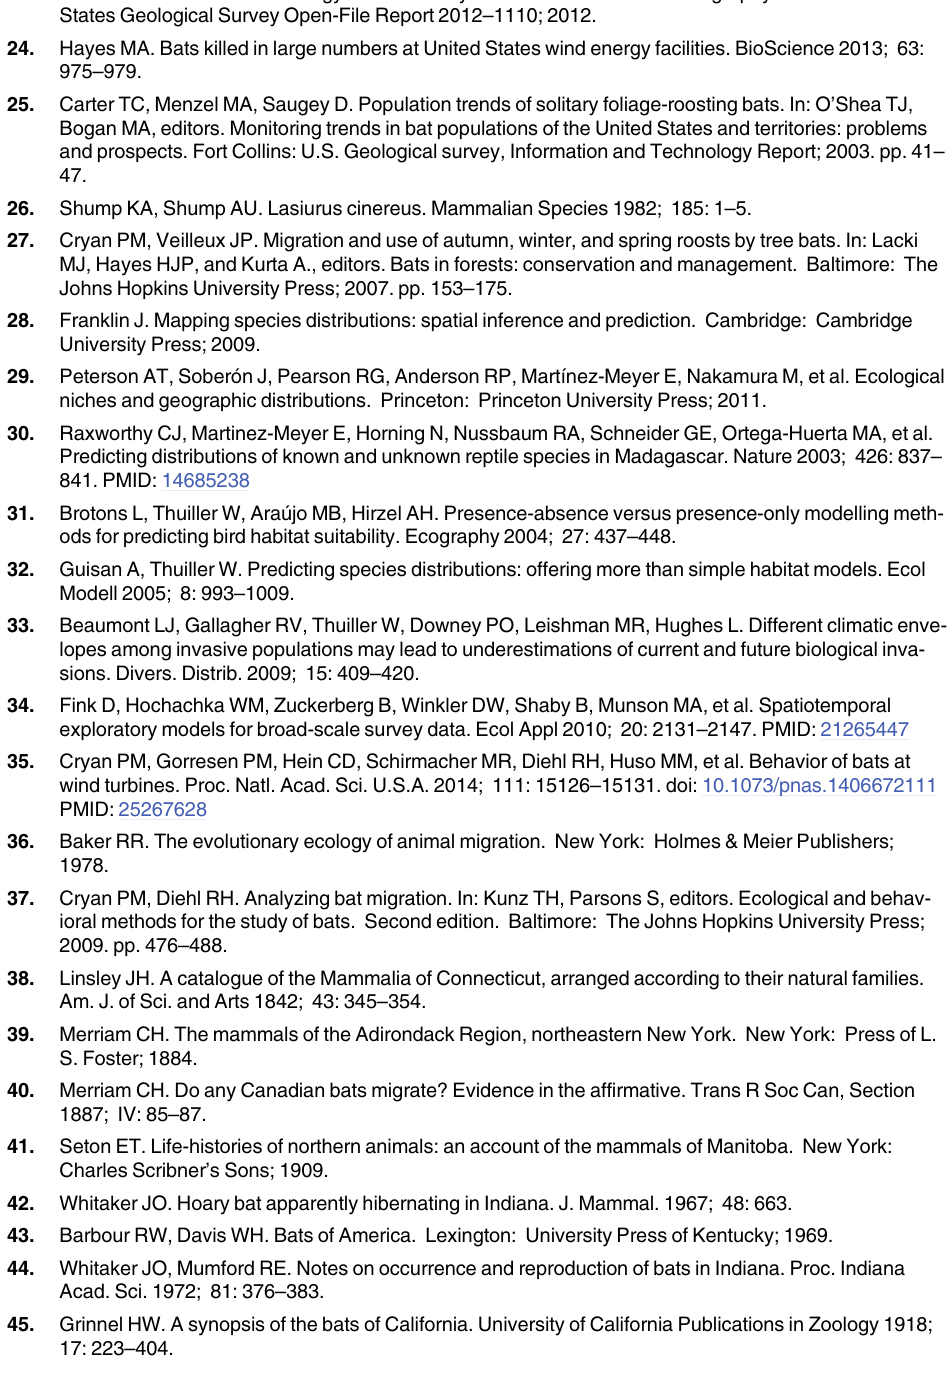
PLOS ONE | DOI:10.1371/journal.pone.0132599 July 24,